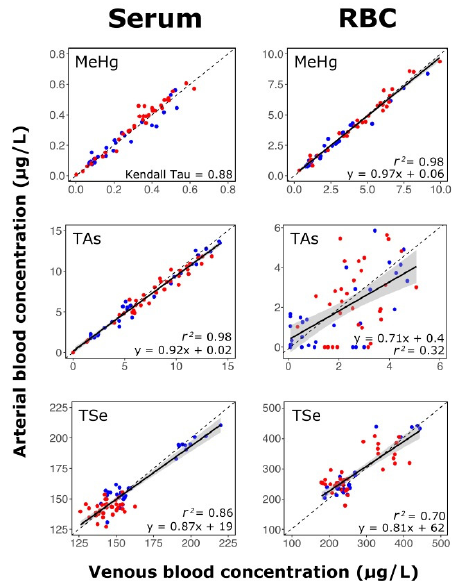
Figure 3. Relationship between the concentration of metal(loid)s in venous and arterial blood for all pigs and sampling times ( n = 72). Blue points represent raw tuna meal, and red points represent cooked tuna meal. The dotted line shows the 1:1 slope, and the solid line signifies a significant regression slope with the gray area illustrating the confidence interval at 0.95.